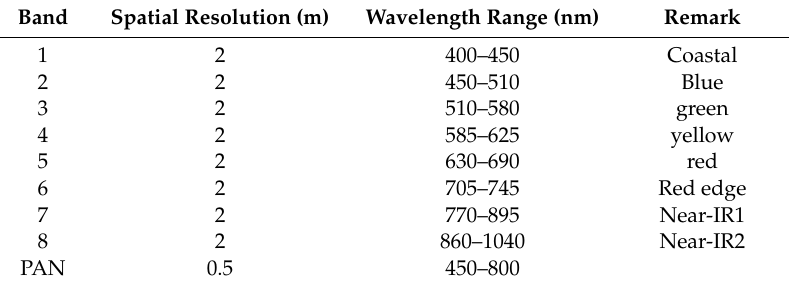
Table 3. Spatial resolution and wavelength range of each band of WorldView-2 satellite imagery.